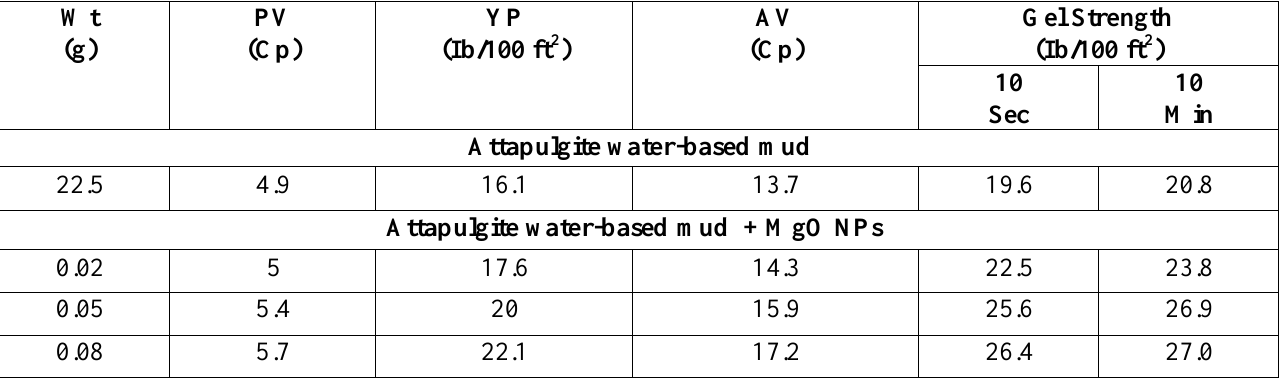
Table 4: Rheological properties of attapulgite water-based mud with different concentration of MgONanoparticles.